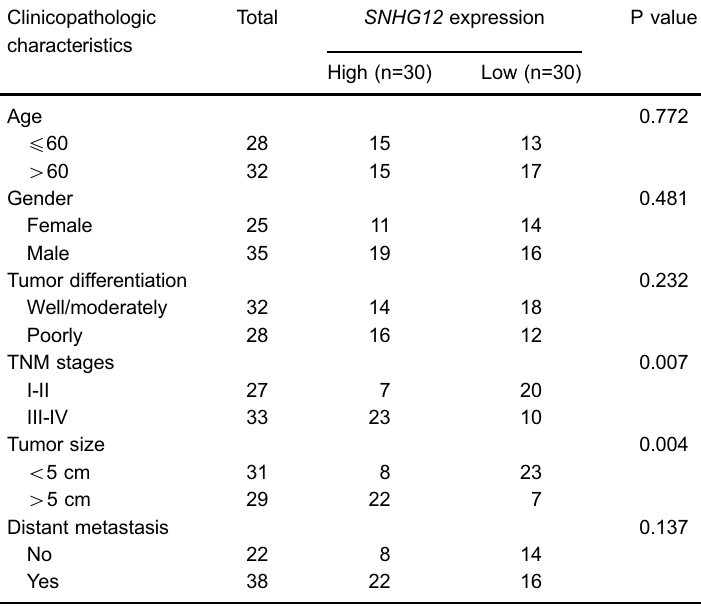
Table 1. Clinical characteristics of the 60 colorectal cancer patients and the correlation with high and low level expression of small nucleolar RNA host gene 12 ( SNHG12 ) in colorectal cancer